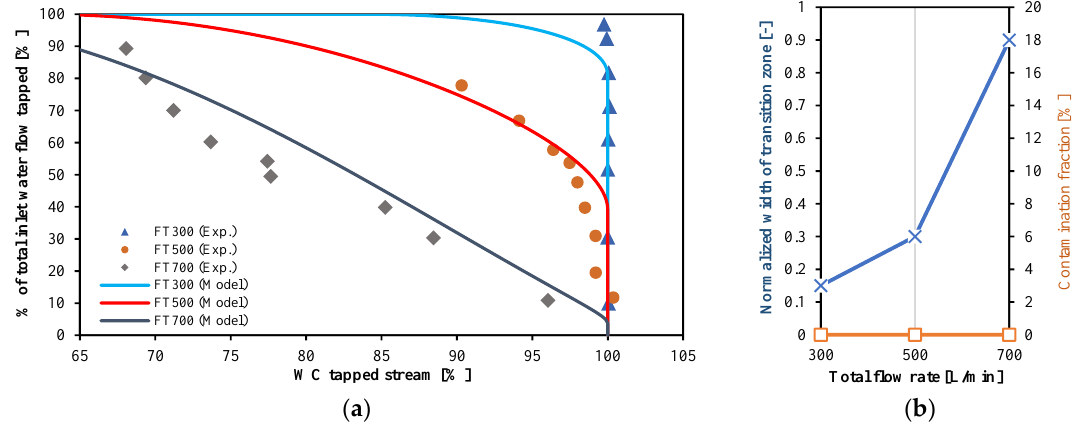
Figure 18. ( a ) Comparison between model prediction and experimental data for unspiked oil with WC inlet 50% and total flow rates 300, 500, and 700 L/min, ( b ) Changes of normalized width of transi- tion zone (blue line) and contamination fraction (orange line) vs. flow rates. Figure 19a presents the comparison between the experimental data and model for the data set nr. 2. The agreement between the model and data is also satisfactory. Adding crude oil to Exxsol D60 increases the normalized width of transition zone and make 15% contamination in water-rich and oil-rich streams (Figure 19b).